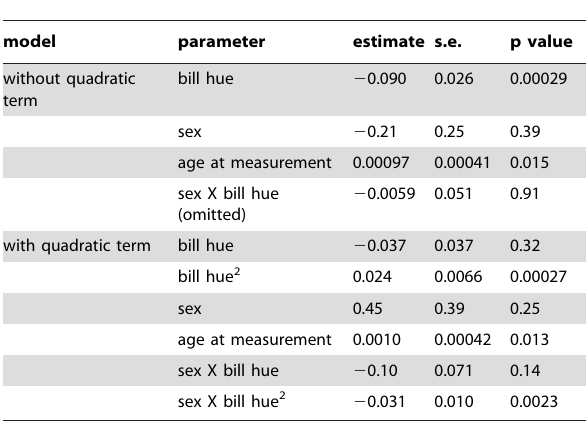
Table 1. Proportional hazard models including both sexes.